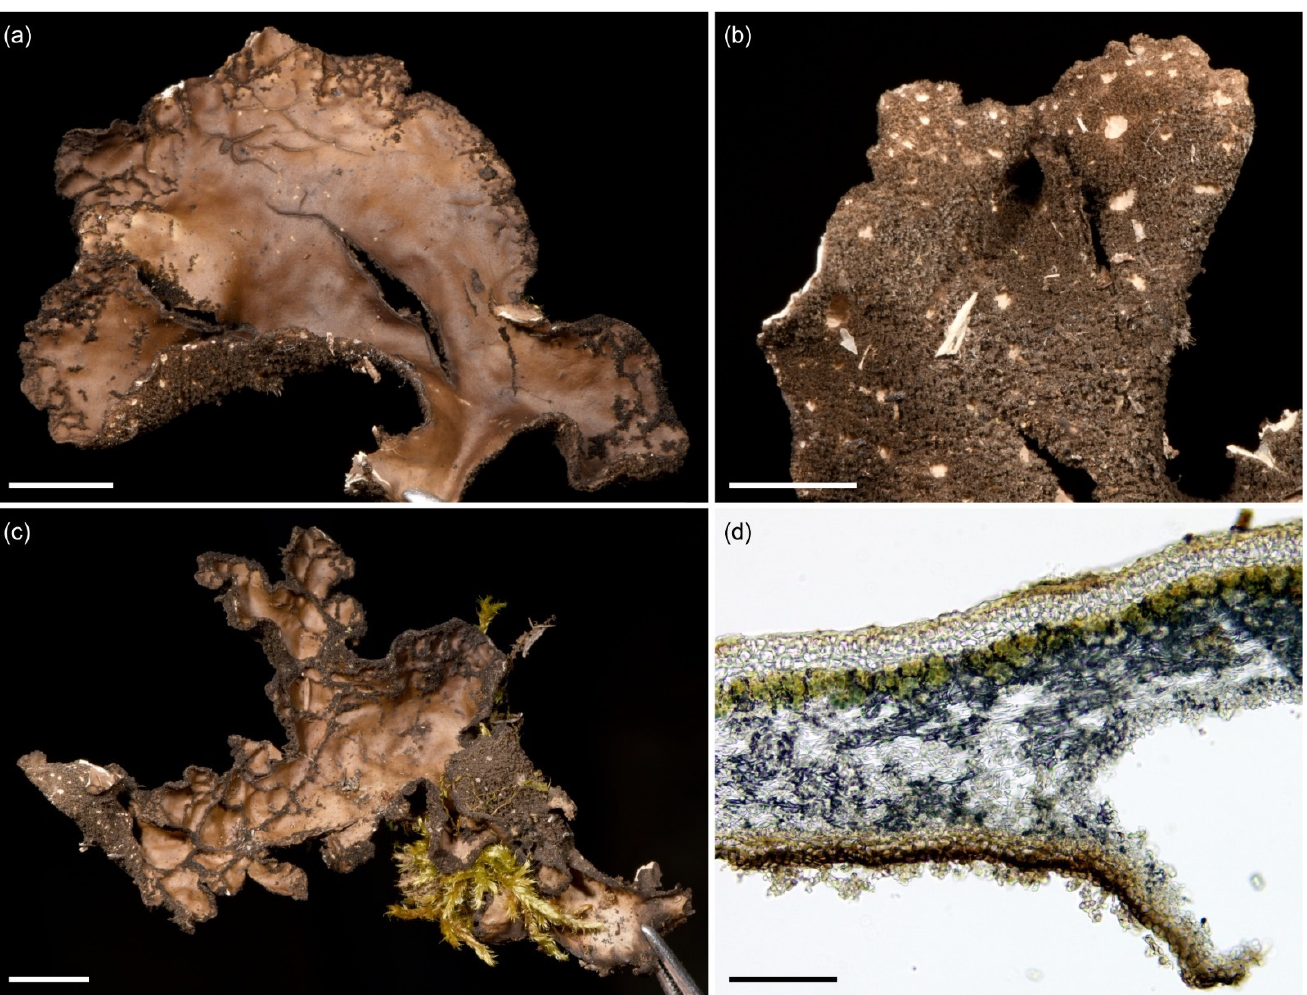
Figure 9. Sticta cellulosa . ( a , b ) Type specimen UK171406e imaged from the upper and lower side. ( c ) Thallus part of the same collection as type specimen with abundant characteristic isidiate ridges. ( d ) Thallus cross section with a cyphella on the right showing the epapillate cells of the cyphellar membrane, and the moniliform assemblages which form secondary tomentum on the lower surface (UK171340t). Scales 0.5 cm in ( a – c ), 100 µm in ( d ). Type: Tanzania , Mt. Kilimanjaro, near Umbwe Route, subalpine Erica trimera forest, − 3.1114° N 37.3183° E, 3500 masl, 18 June 2017, on fallen branch, U. Kaasalainen